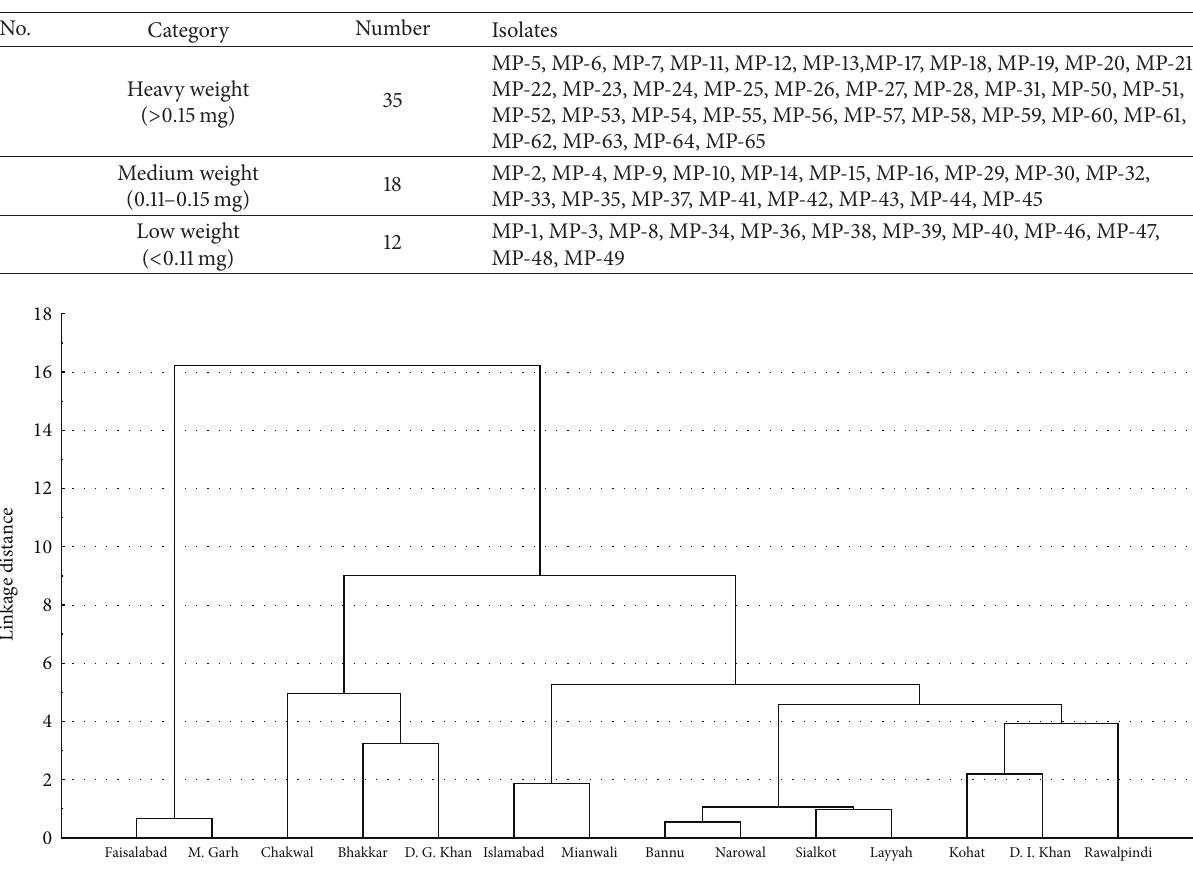
Figure 1: Dendrogram derived from cluster analysis (UPGMA) showing relationship among the 65 isolates of M. phaseolina on the basis of morphological characters collected from 14 districts of Punjab and KPK